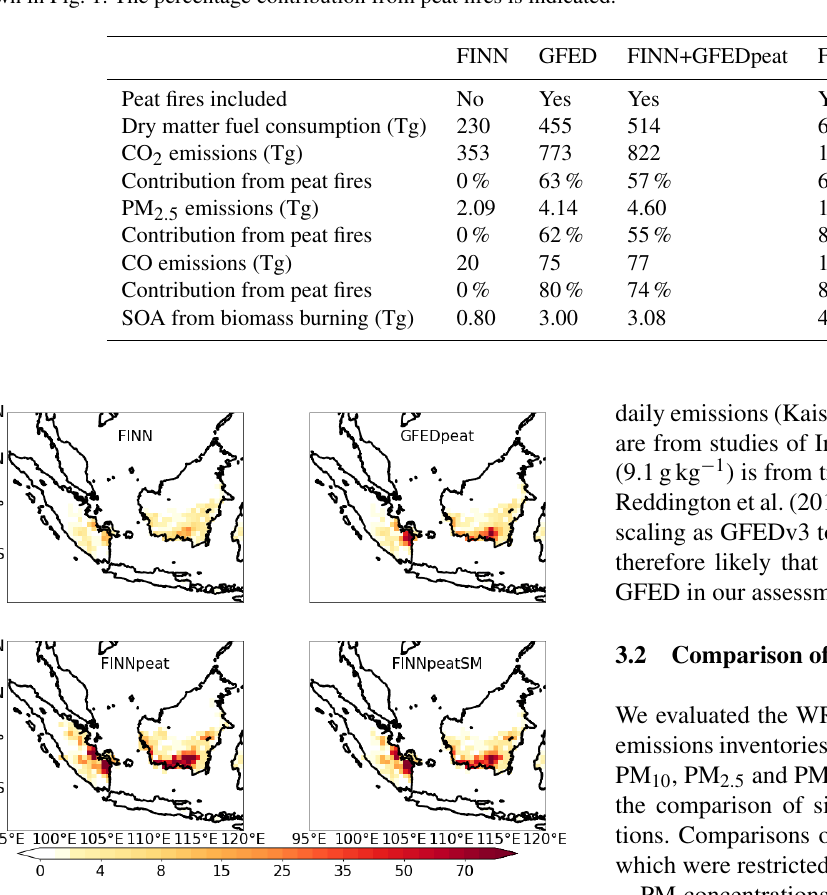
Figure 2. Total PM 2 . 5 fire emissions during September–October 2015 (gm − 2 ).